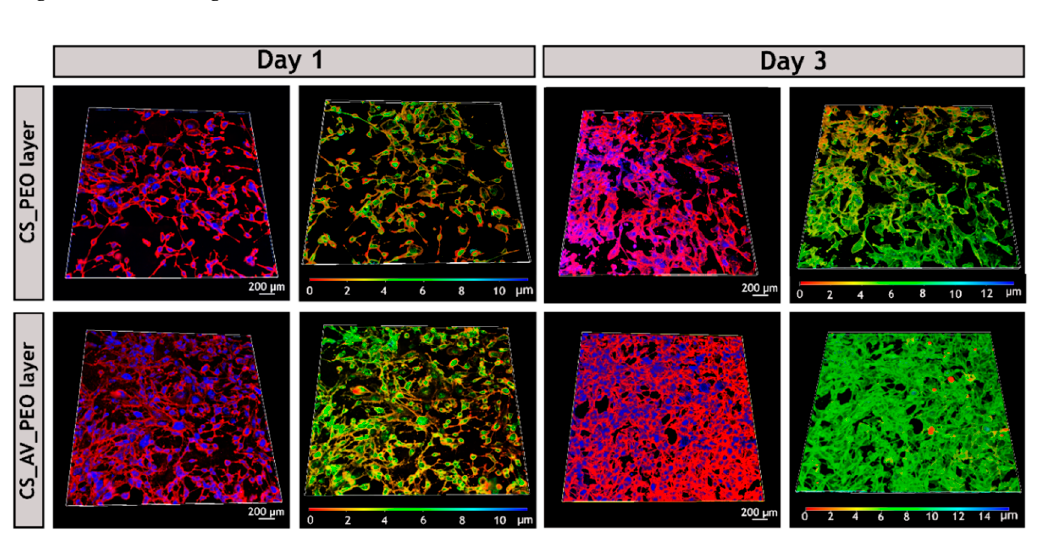
Figure 8. Confocal laser scanning microscopy (CLSM) images of fibroblast cells cultured on the surface of CS_PEO and CS_AV_PEO layers and color coded depth analysis (red 0 μ m, blue 10–14 μ m) after 1 and 3 days. Blue channel: cell nuclei labeled Hoechst 33342 ® ; red channel: cytoplasm stained with WGA-Alexa 594 ® conjugate.